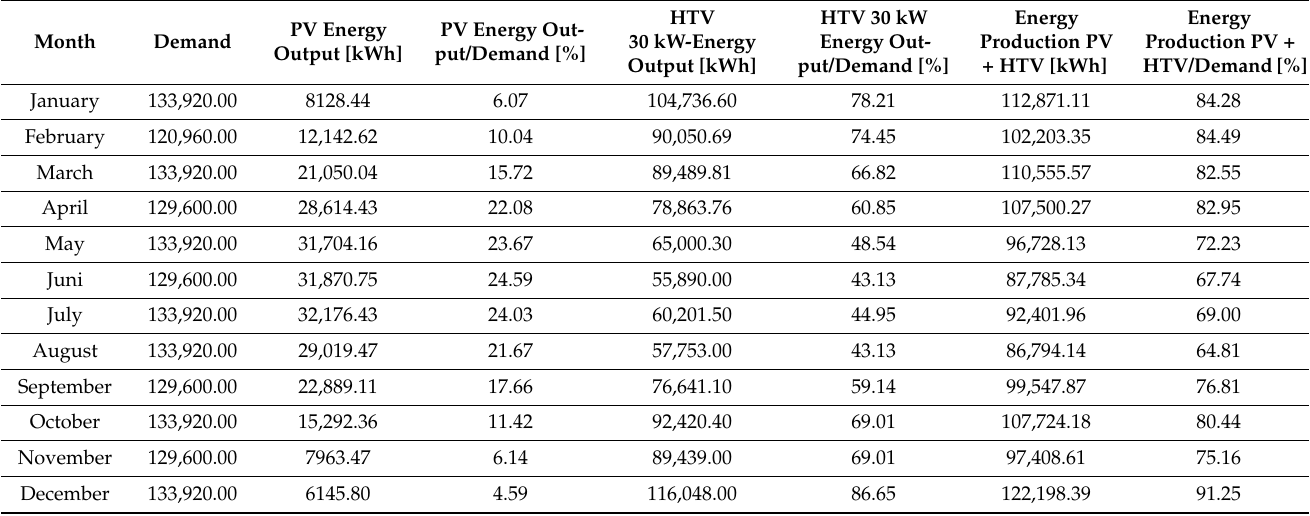
Table 11. Average amounts of energy generated by PV installations and windmill systems